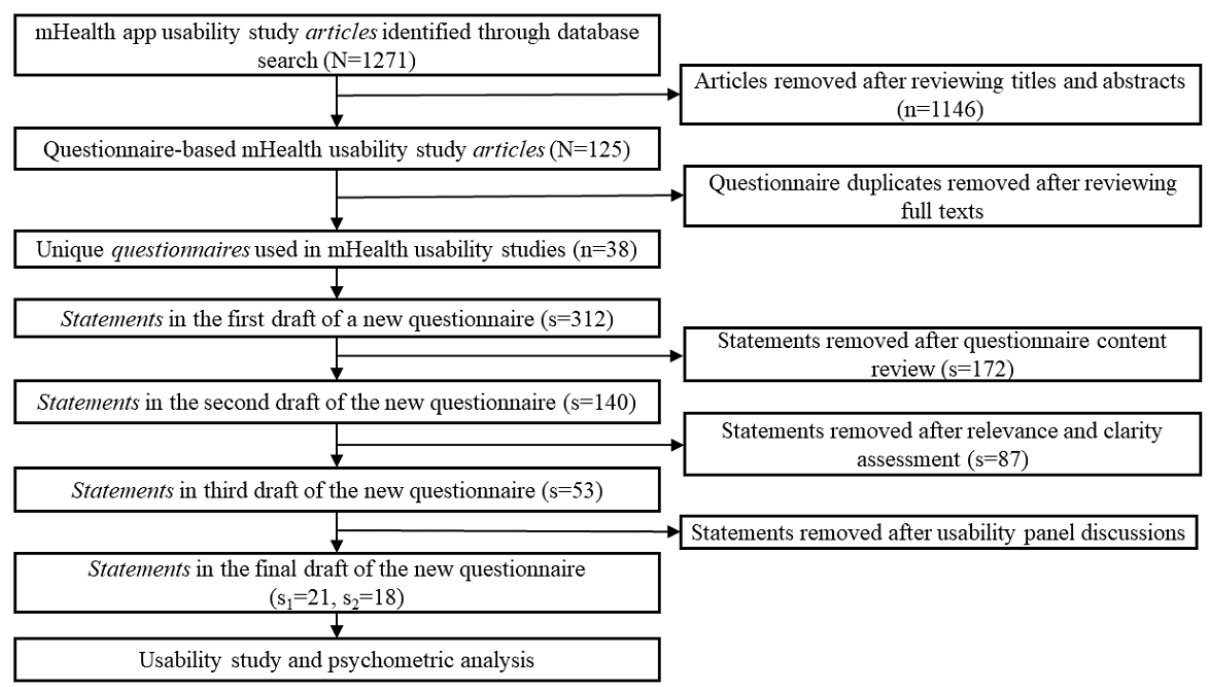
Figure 1. A flow chart of the new usability questionnaire development and validation. mHealth: mobile health; s: number of statements; s1: